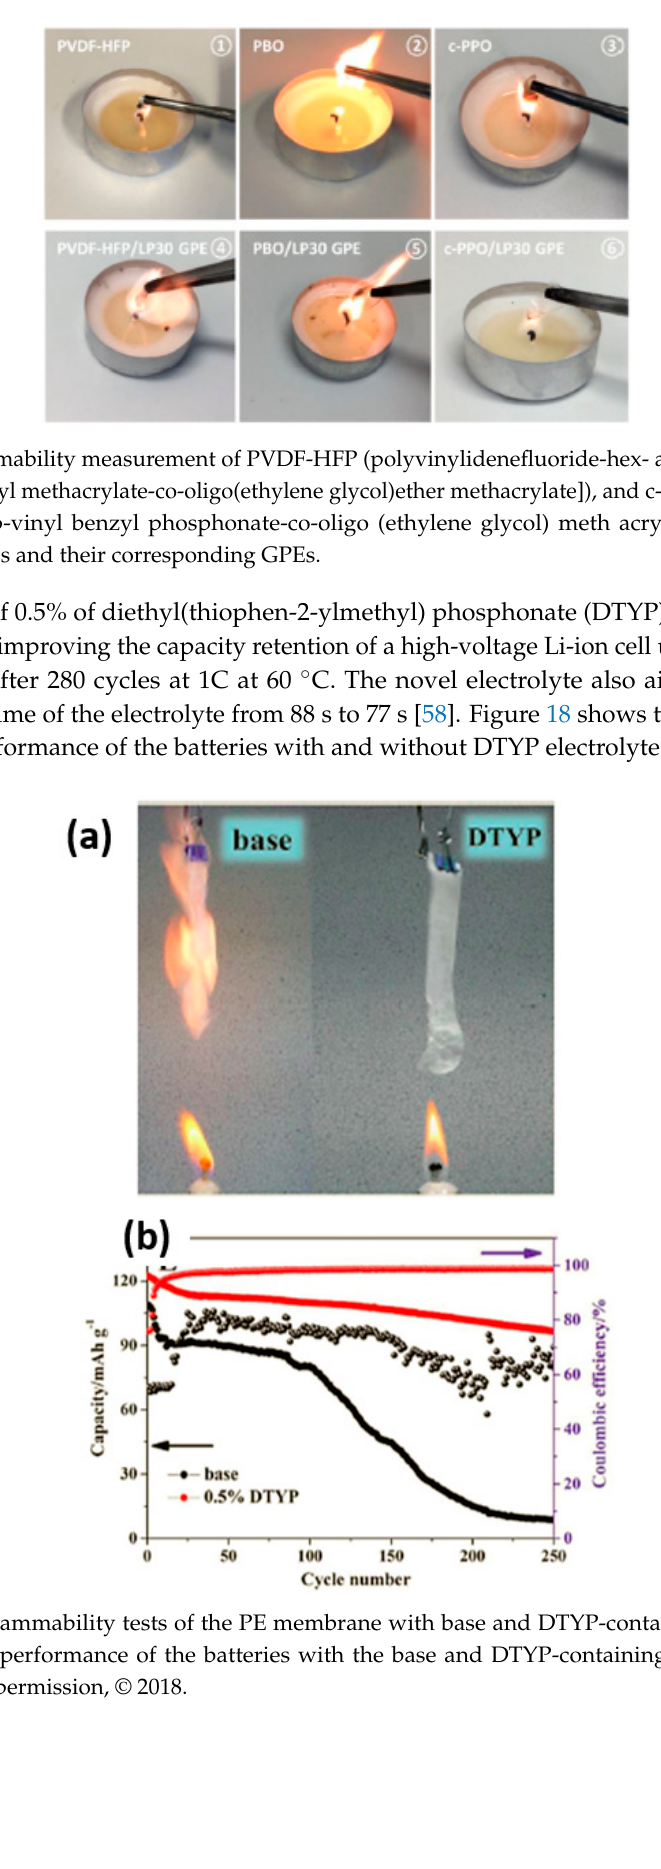
Figure 19. Cycling performance of LiFePO 4 /Li solid-state Li-ion batteries with poly(ethylene oxide)/LiTFSi/10% Mg 2 B 2 O 5 at 50 °C [59], © 2018.